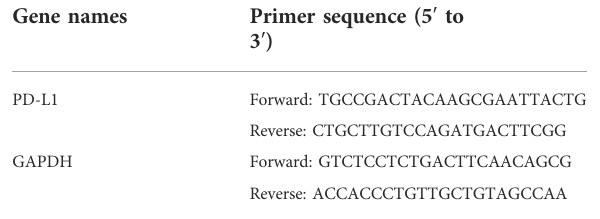
TABLE 1 Primer sequences used for